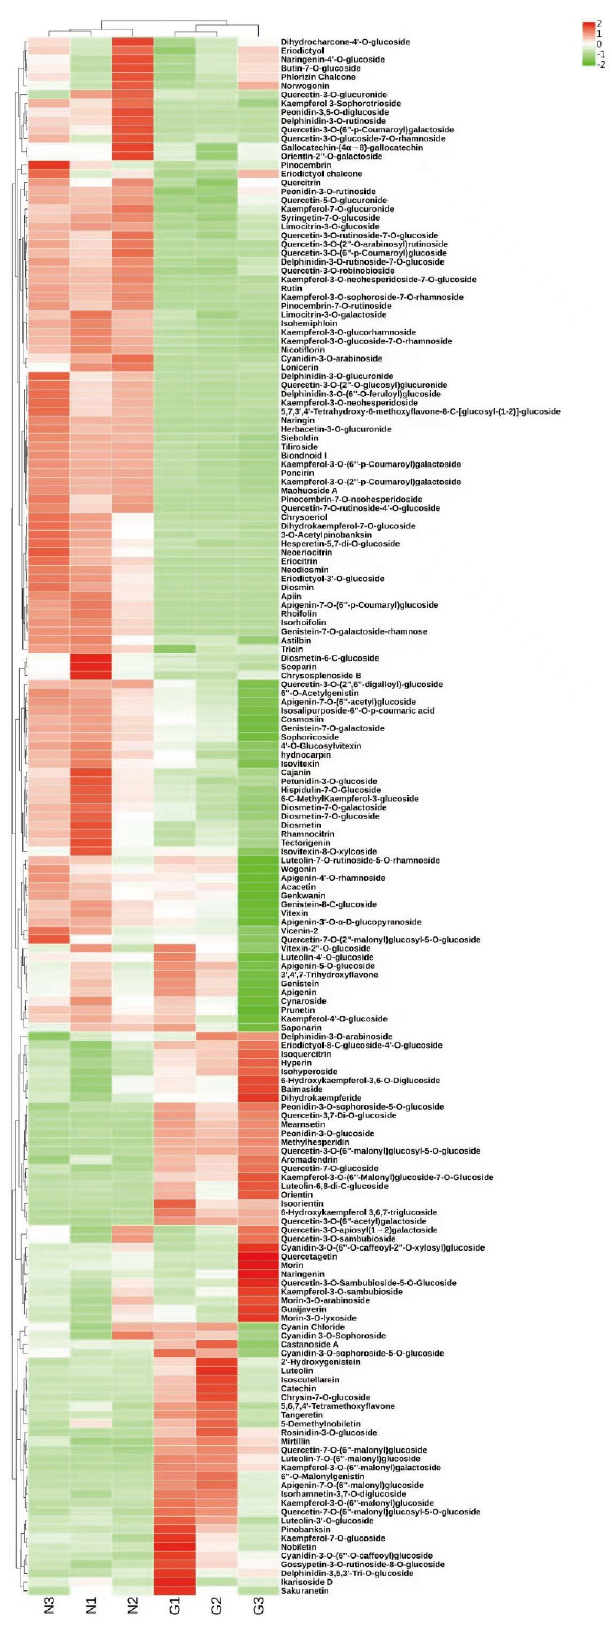
Figure 2. Heat map of the relative content of flavonoids in G type and N type (different colors represent Z-score normalized values for the relative content of metabolites; red represents high compound content, green represents low compound content).